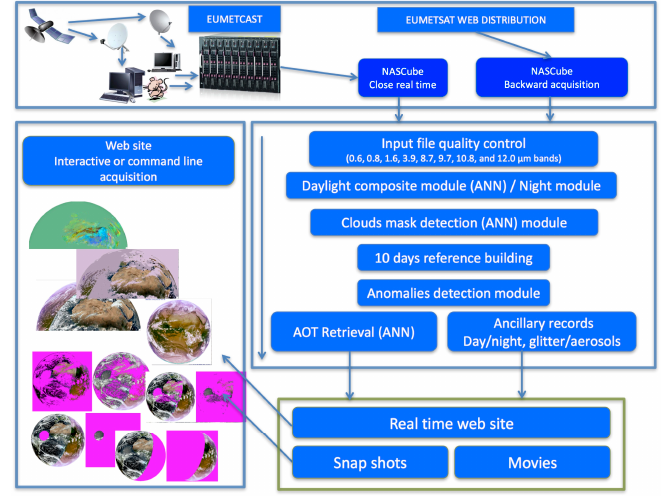
Figure 2. NASCube flowchart. NASCube system is divided in three levels: The first level is devoted